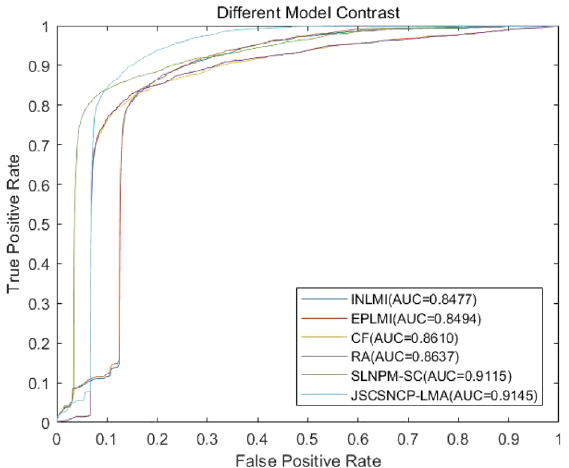
Figure 6. Prediction abilities with different models. The figure shows the ROC curves and AUC values of the six methods (INLMI, EPLMI, CF, RA, SLNPM-SC, JSCSNCP-LMA) by using fivefold CV.